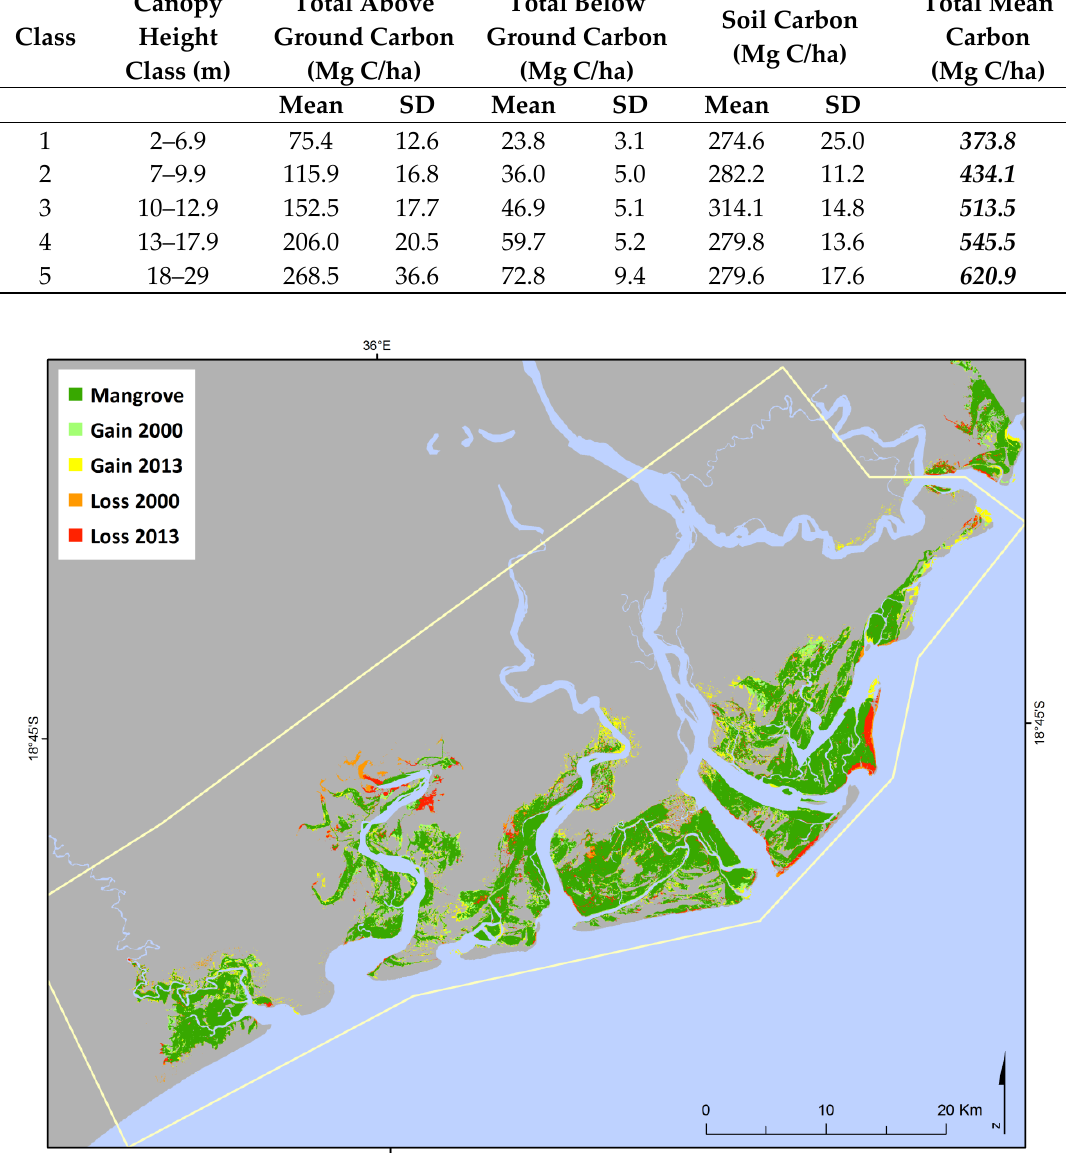
Table 2. Carbon densities within canopy height classes of the above- and belowground biomass and soil pools [4].